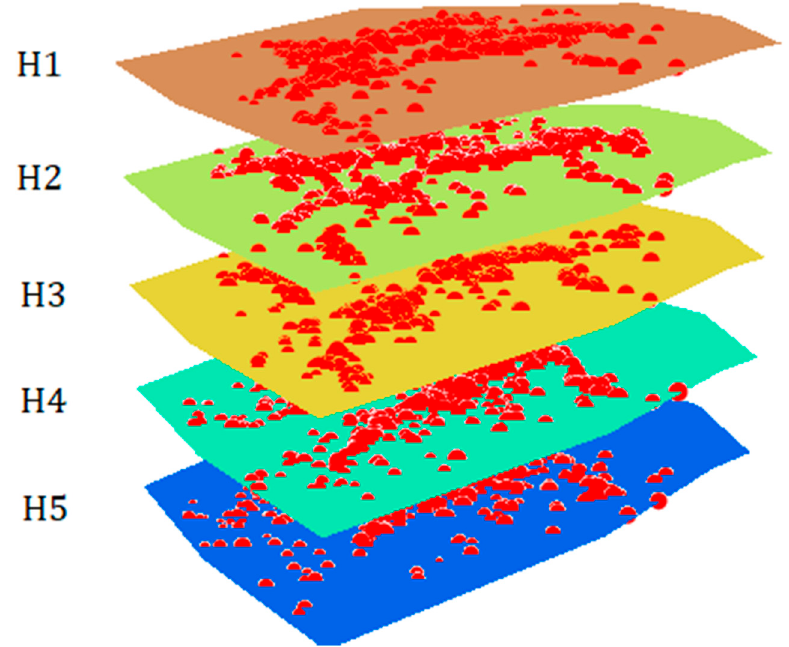
Figure 6. Distribution of the seismic events in different depth layers.